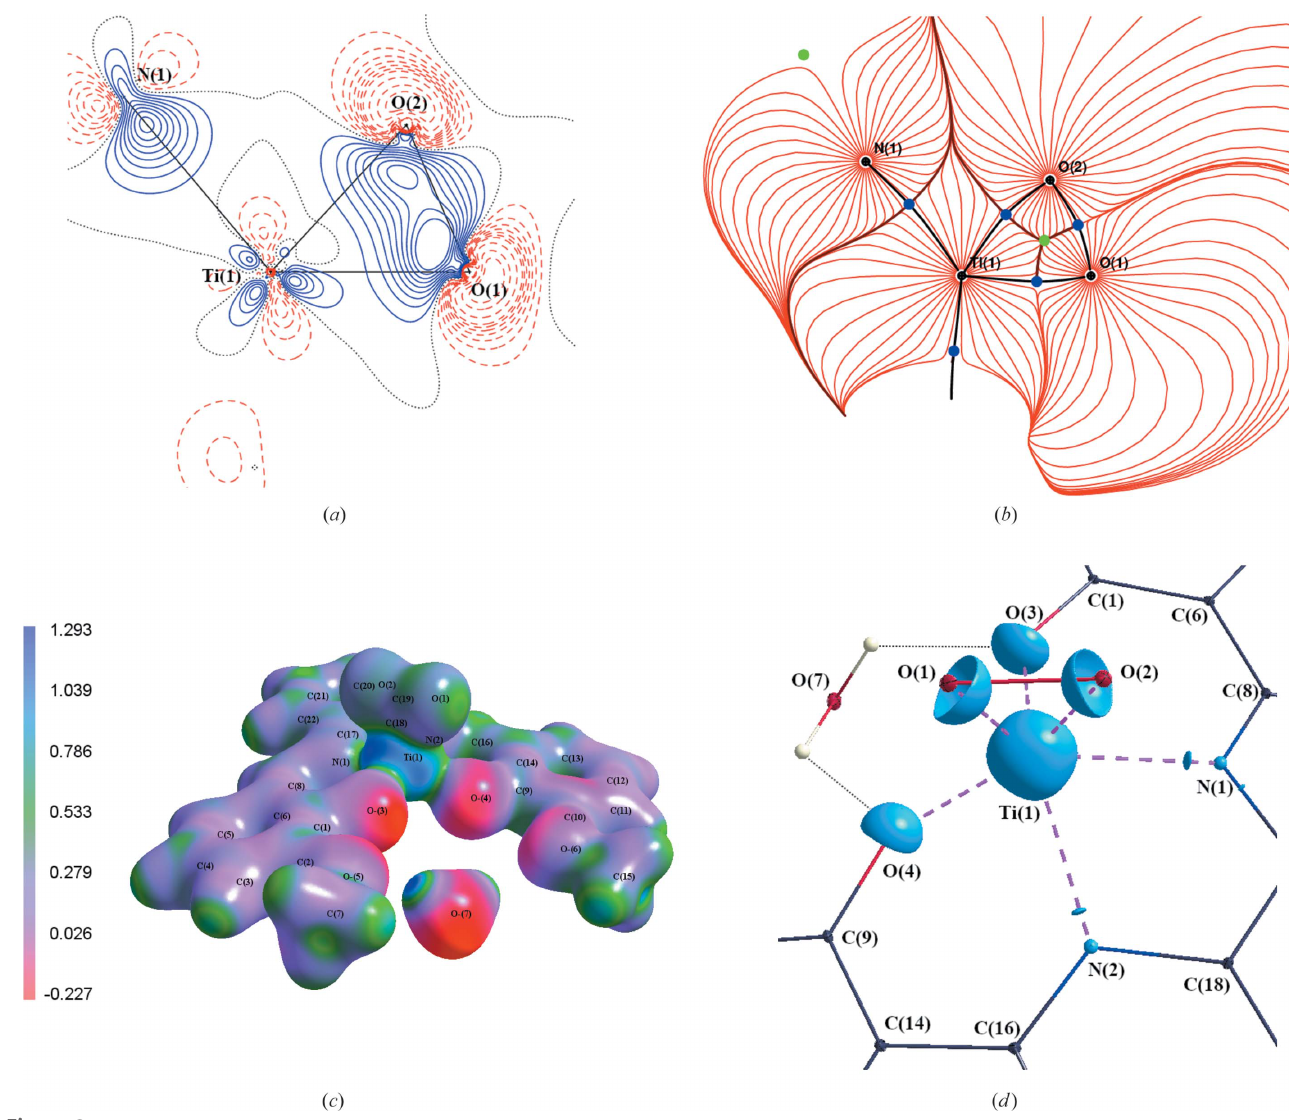
Figure 3 ( a ) Static electron deformation density in the plane defined by the atoms Ti(1)—O(1)—O(2). Contour spacing 0.1 e A˚ (cid:3) 3 , with positive contours drawn with a solid blue line and negative contours with a dashed red line; ( b ) gradient field trajectory plot of electrostatic potential in the plane Ti—O(1)— O(2); ( c ) experimental electrostatic potential on the 3D-isosurface of the experimental electron density (0.3 e A˚ (cid:3) 3 ); ( d ) three-dimensional plot (Hu¨bschle & Dittrich, 2011) of the Laplacian of electron density around Ti at an isosurface value of 80 e A˚ (cid:3) 5